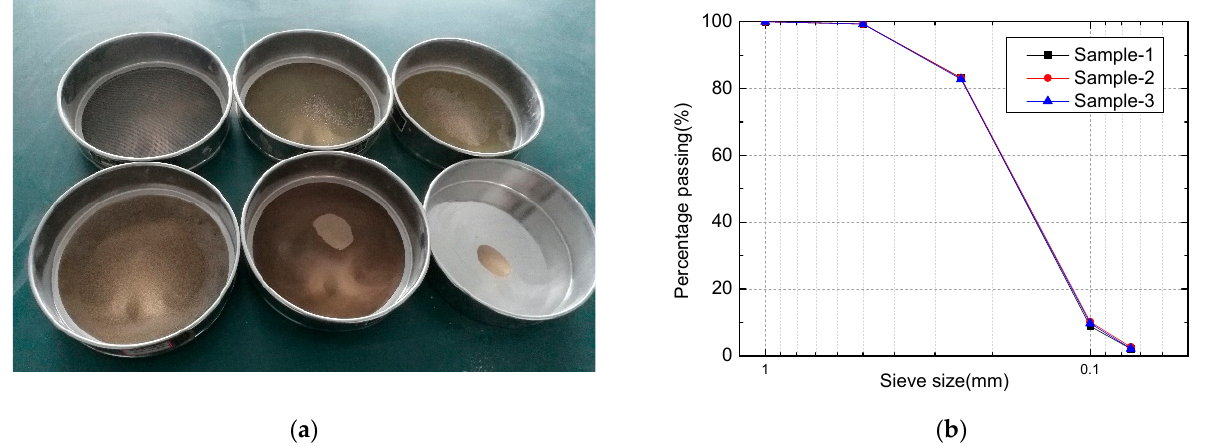
Figure 1. Sieving analysis of sand: ( a ) Sand after sieving; ( b ) Particle size distribution of sand.